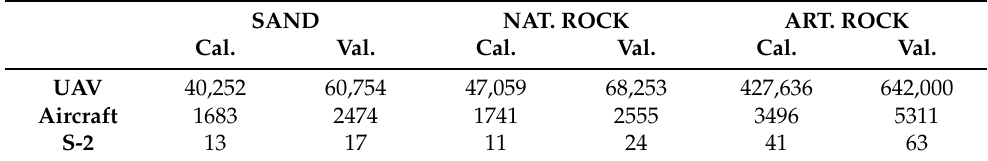
Table 6. Number of points used for each type of orthophoto (UAV, aircraft and S-2) in the two different sets (calibration and validation) for the three considered classes (sand, artificial and natural rocks). Portosole extended area. SAND NAT. ROCK ART. ROCK